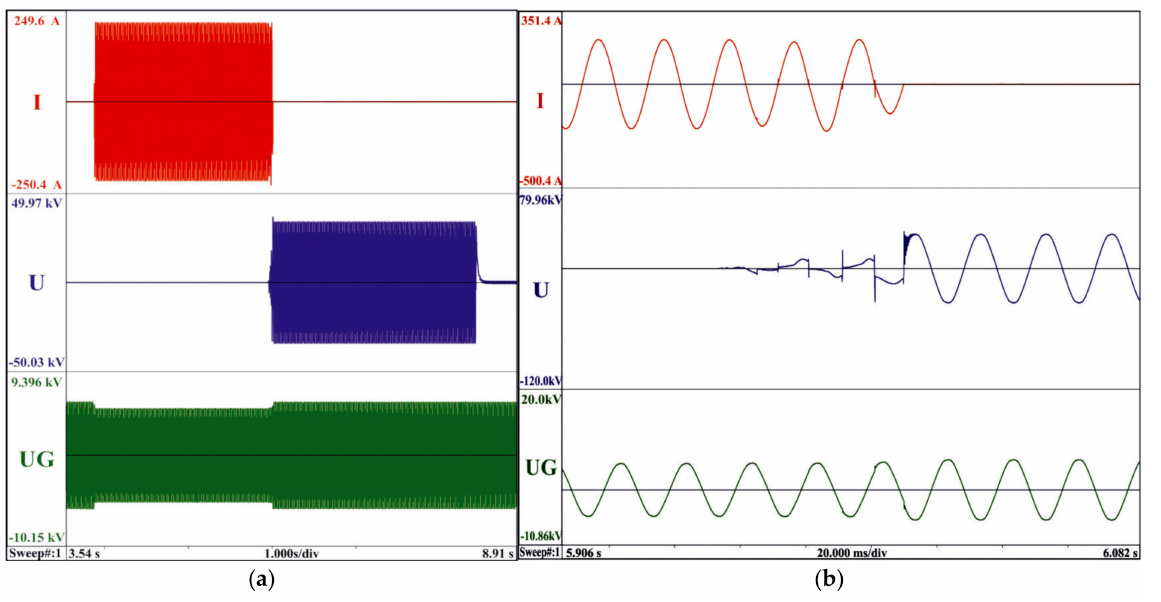
Figure 16. ( a ) Oscillogram obtained during the first test for the minimum breaking current a, overview; ( b ) detail of the oscillogram.